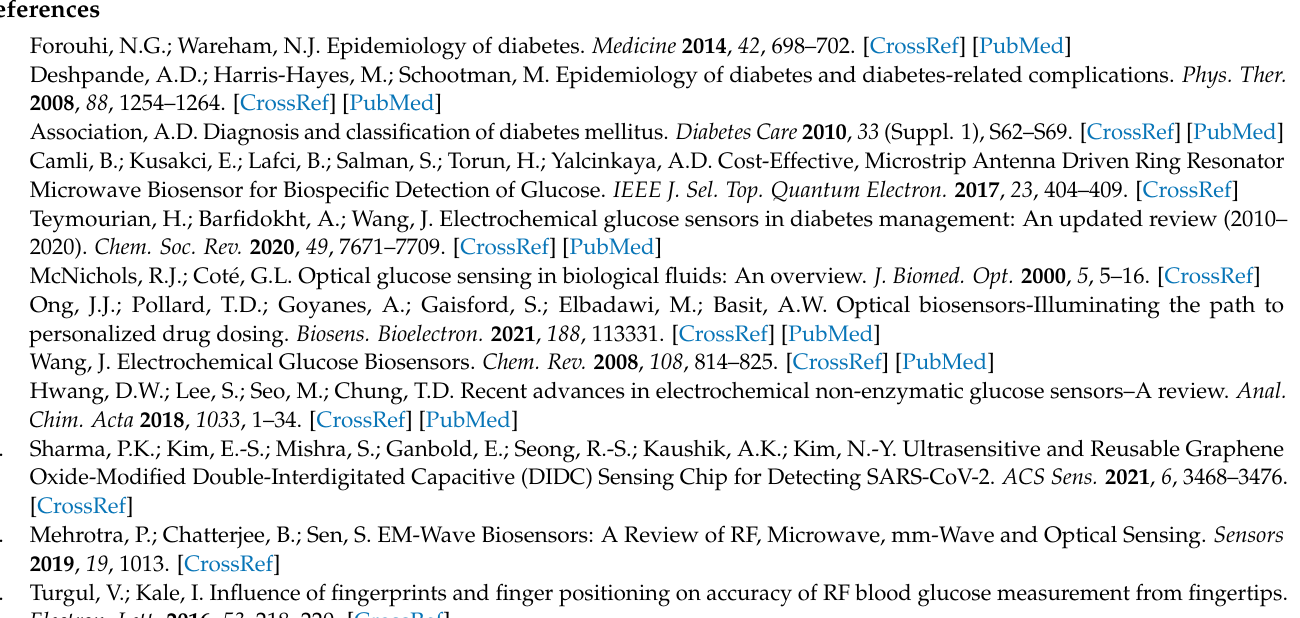
curves. Figure S3: The variations in response of 100 mg/dL glucose and fructose dissolved in serum with/without glucose oxidase. Figure S4: Different mixture response curves. Figure S5: Reaction principle. Figure S6: Response curves for different glucose concentrations in serum. Table S1: RSD calculation of the peak 2 frequency. Table S2: 8719E full frequency band sweep time (0.05 to 13.5 GHz